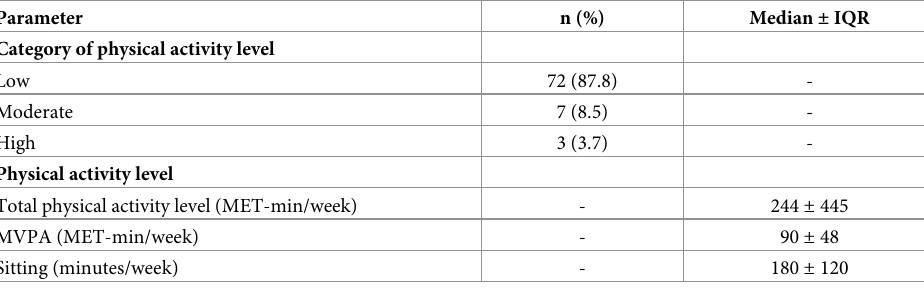
Table 2. Status of physical activity based on IPAQ (n =